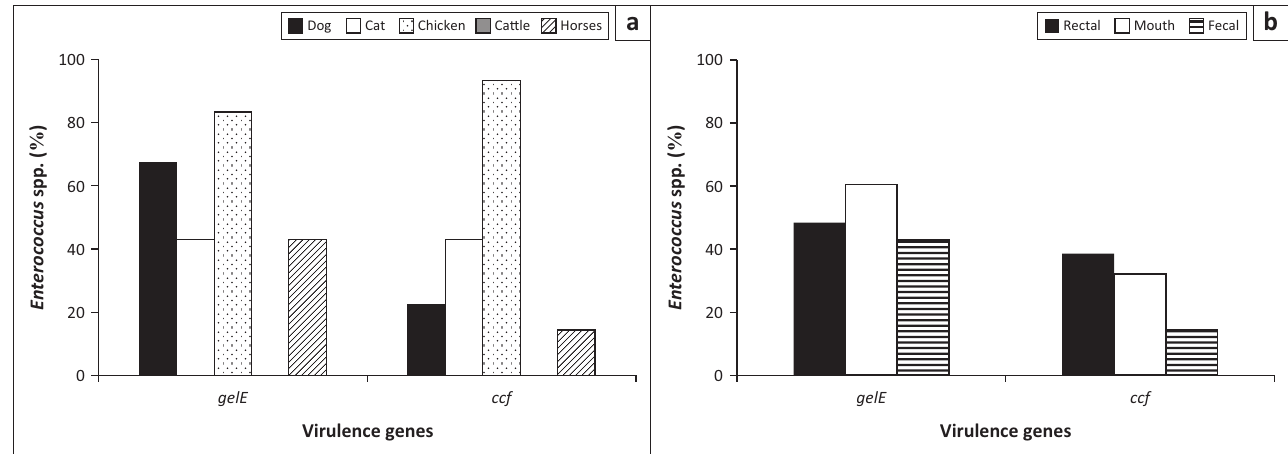
FIGURE 3: (a) Virulence genes within animal species and (b) virulence genes within site of collection – prevalence of virulence genes detected in each animal species and within each site of collection.